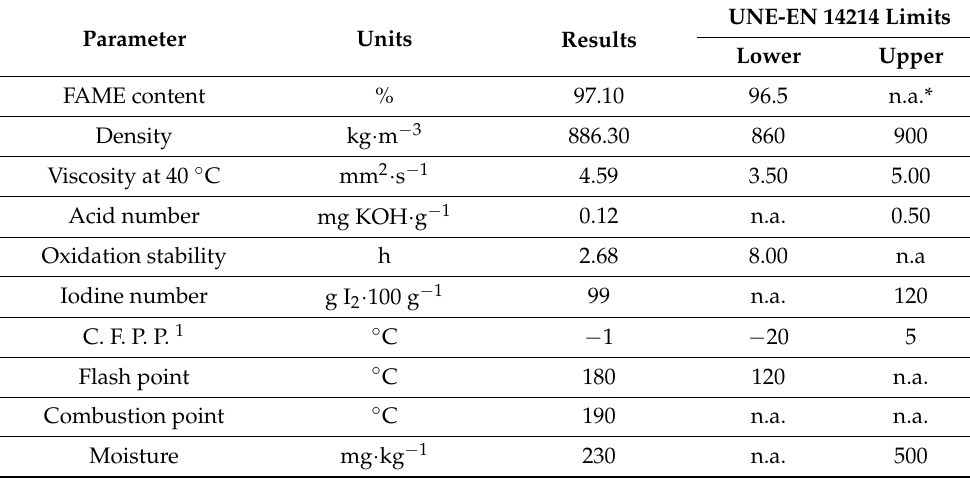
Table 1. FOBD characterization and comparison with the standard.